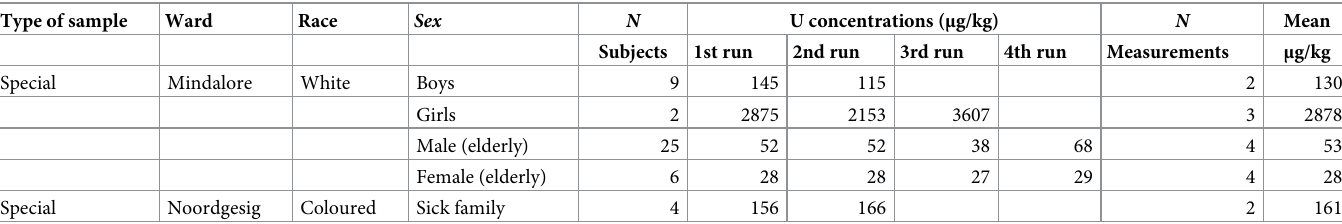
Table 2. Uranium concentration in human scalp hair of 15 measurements in 5 special samples from 46 individuals in Gauteng Province, South Africa.